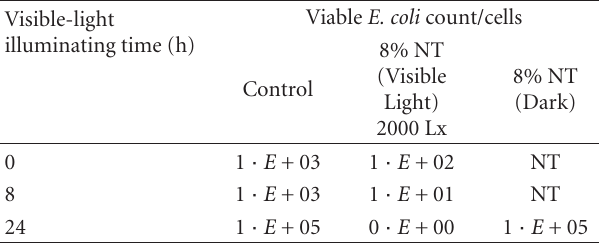
By rinsing the samples with nutrient broth solution containing 10 8 CFU/mL of E. coli for 10sec, 10 3 E. coli cells were adsorbed on the surface of PTFE hydrophobic composite films. The viable E. coli were all inactivated with visible-light illumination at 2000 lx for 24 hours.